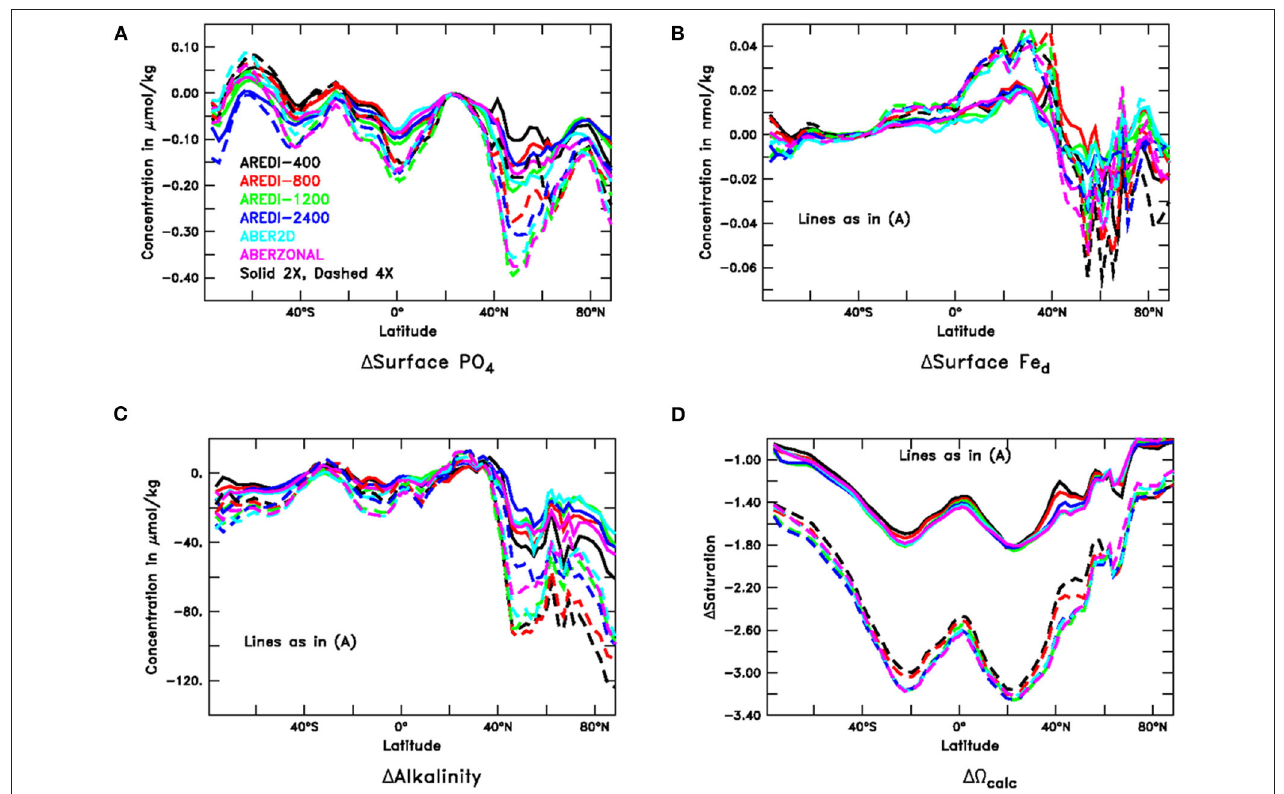
FIGURE 7 | Changes in surface chemical properties for years 40–140 of high CO 2 simulations. Solid lines represent changes under doubled CO 2 ; dashed lines represent changes under quadrupled CO 2. (A) Phosphate ( µ M). (B) Dissolved iron (nM). (C) Alkalinity ( µ M). (D) Calcite supersaturation